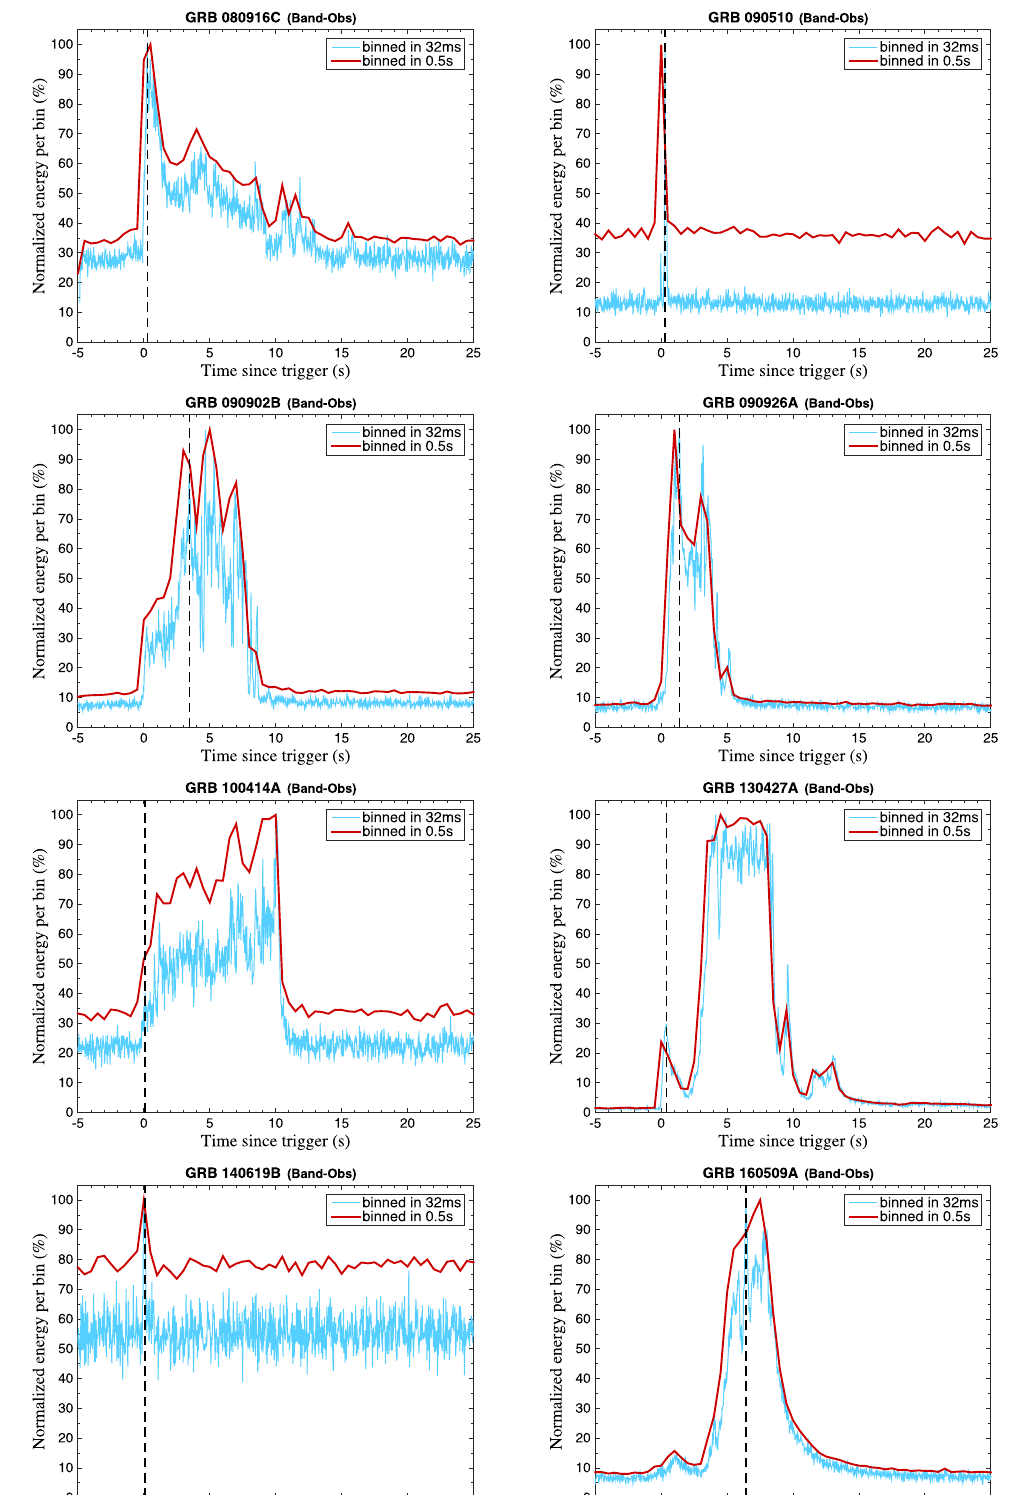
Fig. 3 The energy curves (energy received per bin) in Band-Obs of 8 GRBs. The x -axis is Δ t obs /( 1 + z ) . The thin curves (blue) are the energy curves binned in 0.032 s and the thick (red) curves are those binned in 0.5 s. The y -axis is the normalized energy received, i.e., the